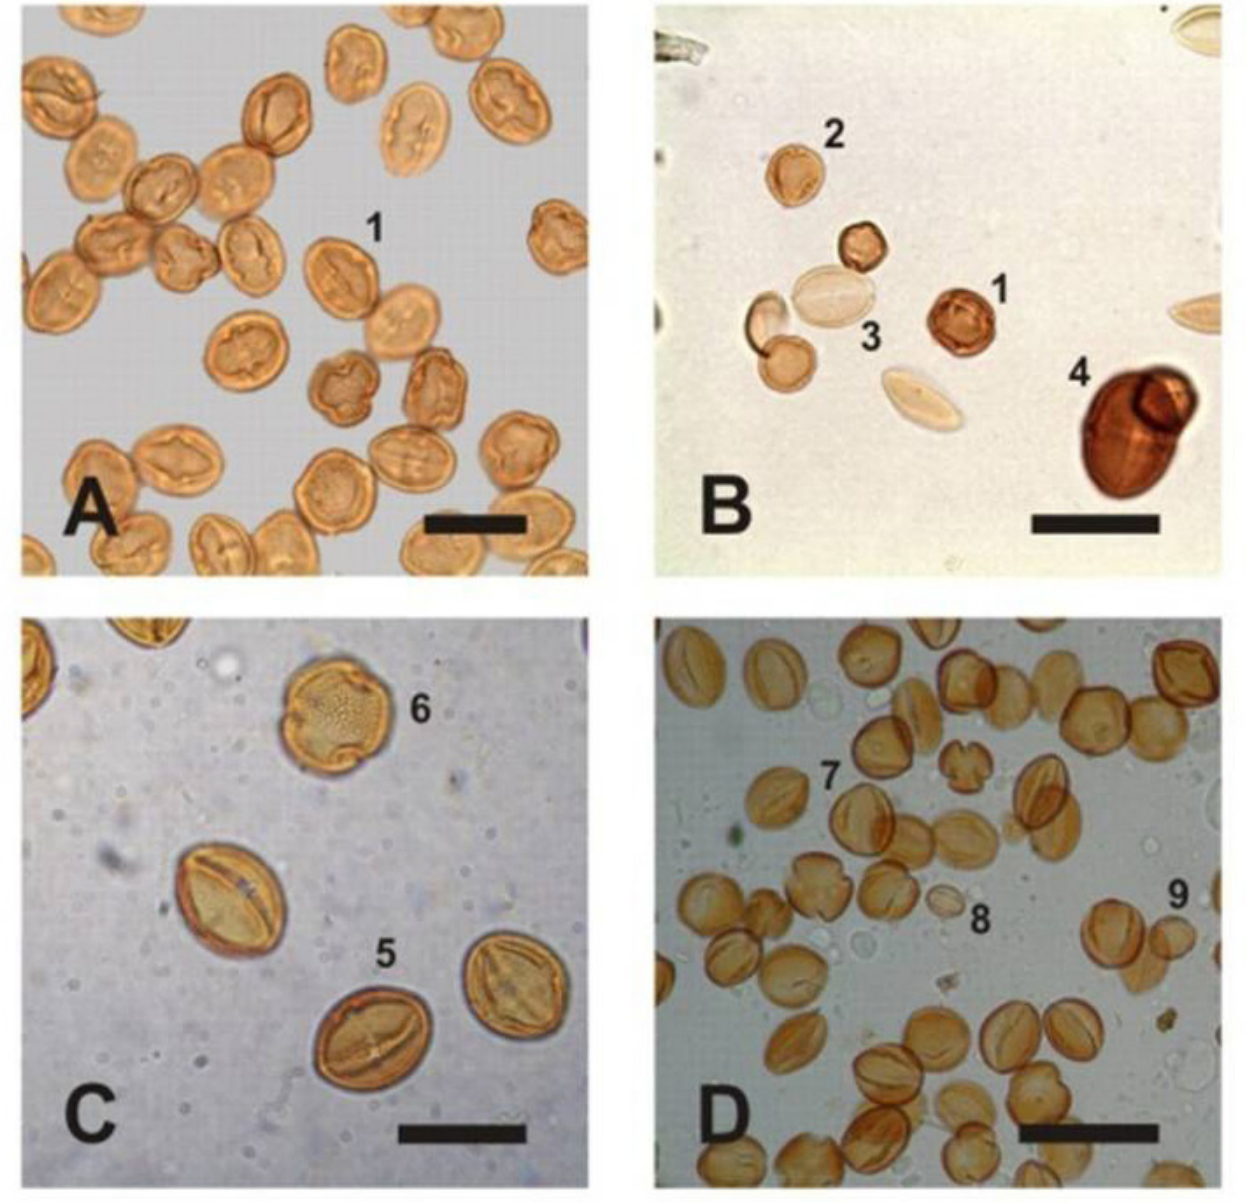
Fig 5. Acetolyzed pollen grains from nest stores, seen in light microscope at 40 x magnification. A–D - Pollen grains of type Schinopsis (Anacardia- ceae) (1), Celtis (Celtidaceae) (2), Trithrinax schizophylla (Arecaceae) (3), Sapium haematospermum (Euphorbiaceae) (4), Capparis retusa (Cappa- ridaceae) (5), Castela coccinea (Simaroubaceae) (6), Prosopis (Fabaceae, Mimosoideae) (7), type Maytenus vitis-idaea (Celastraceae) (8), Ziziphus mistol (Rhamnaceae) (9). Bars: 30 µm (A and C); 40 µm (B); 50 µm